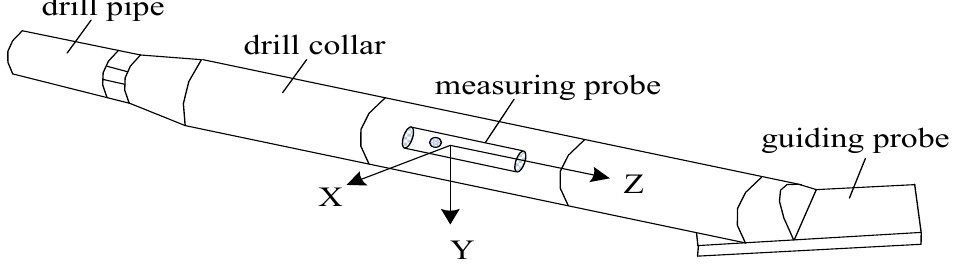
Figure 1. The configuration of a logging tool.